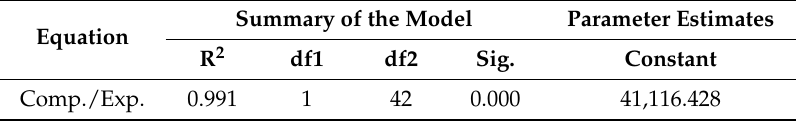
Table 13. Summary of the model.